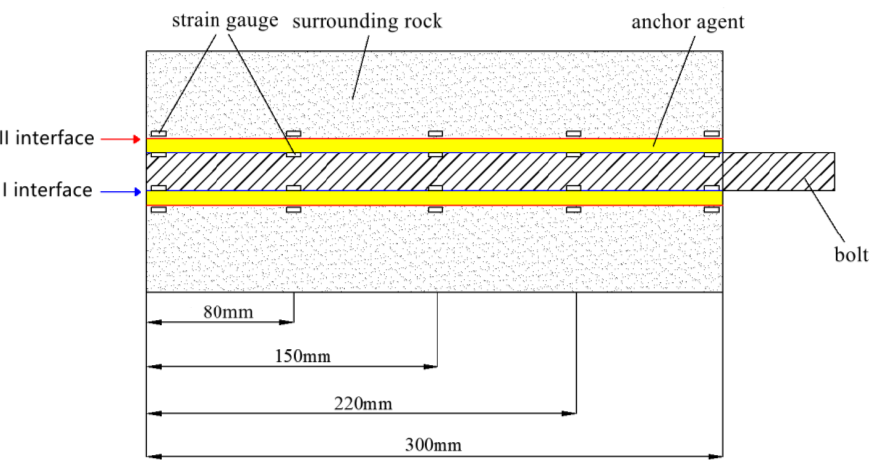
Figure 6. Layout diagram of measuring points.